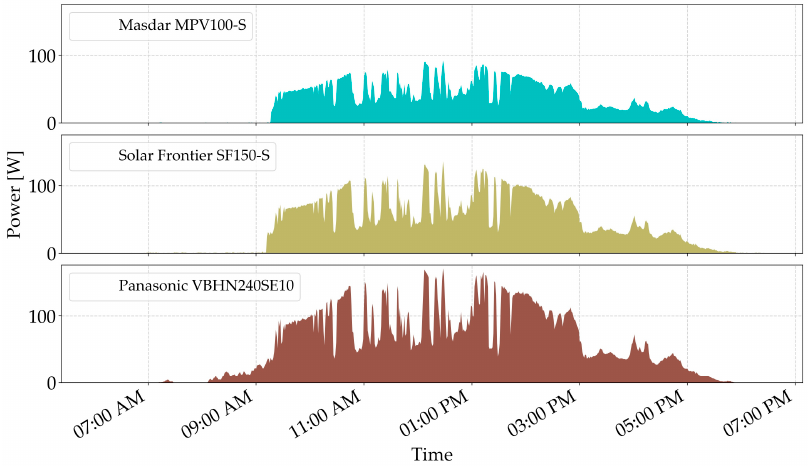
Figure 9. One-minute average values of output power of the a-Si Masdar MPV100-S, Solar Frontier SF150-S, and Panasonic VBHN240SE10 PV modules on 2 September 2018.